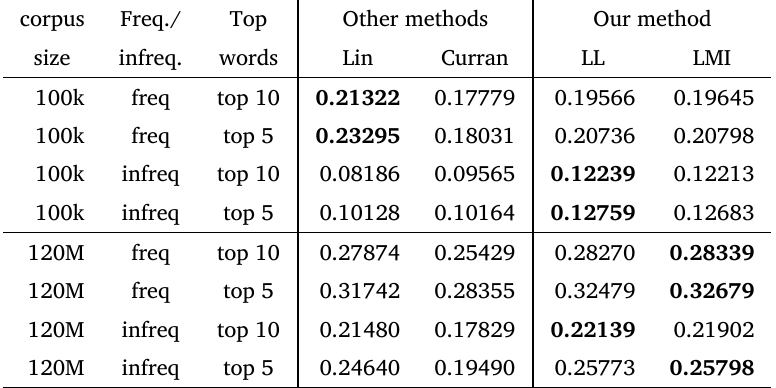
Table 5: Wordnet Path Similarity for 1000 frequent and 1000 infrequent nouns, computed on 100K and 120M sentences comparing our measure to measures by Lin (1998) and Curran (2002) corpus Freq./ Top Other methods Our method size infreq. words Lin Curran LL LMI top 10